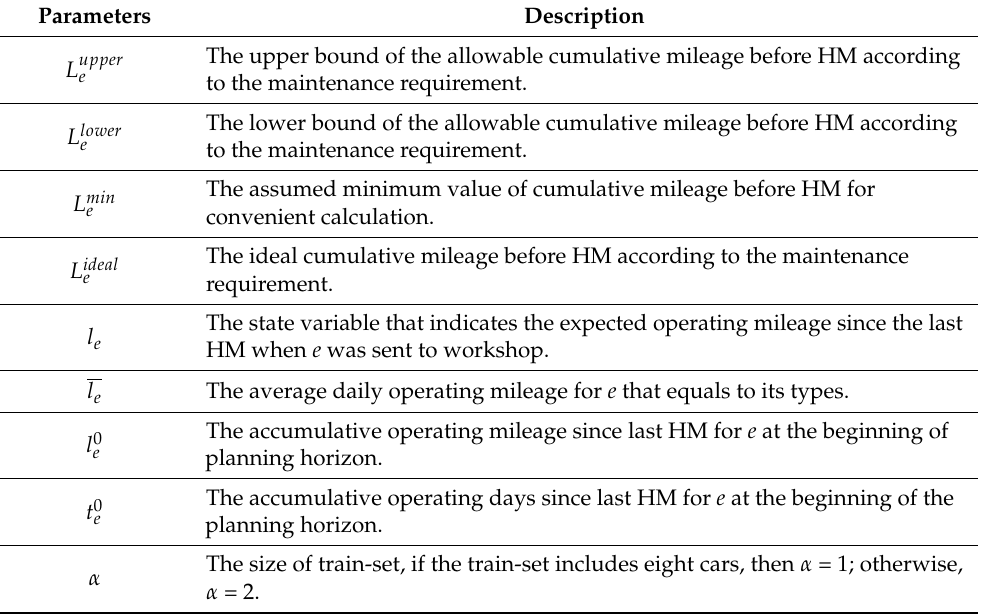
Table 3. Another set of parameters in the model. HM: high-level